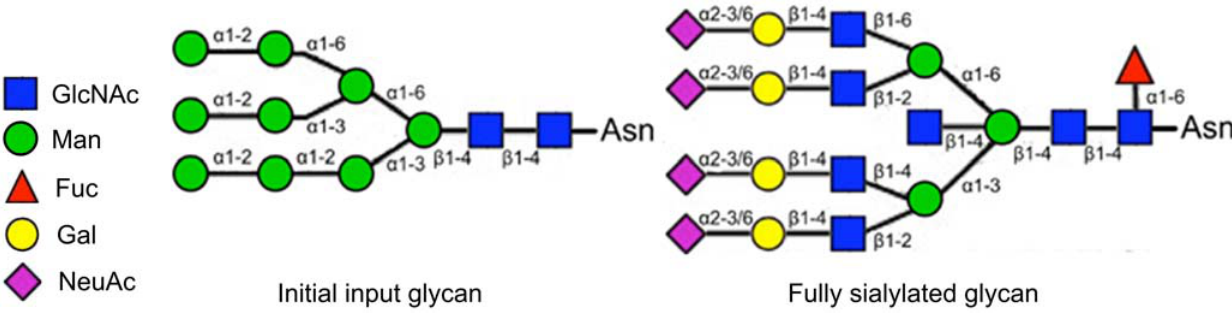
Figure 1. Glycan structures considered in network construction. 9-Mannose glycan enters the N -linked glycan biosynthetic pathways as the starting substrate (left), and can be processed into a fully sialylated complex-type glycan (right). Symbols indicate the sugar residues according to the CFG nomenclature [45]. GlcNAc: N -acetylglucosamine; Man: mannose; Fuc: fucose; Gal: galactose; NeuAc: sialic acid.